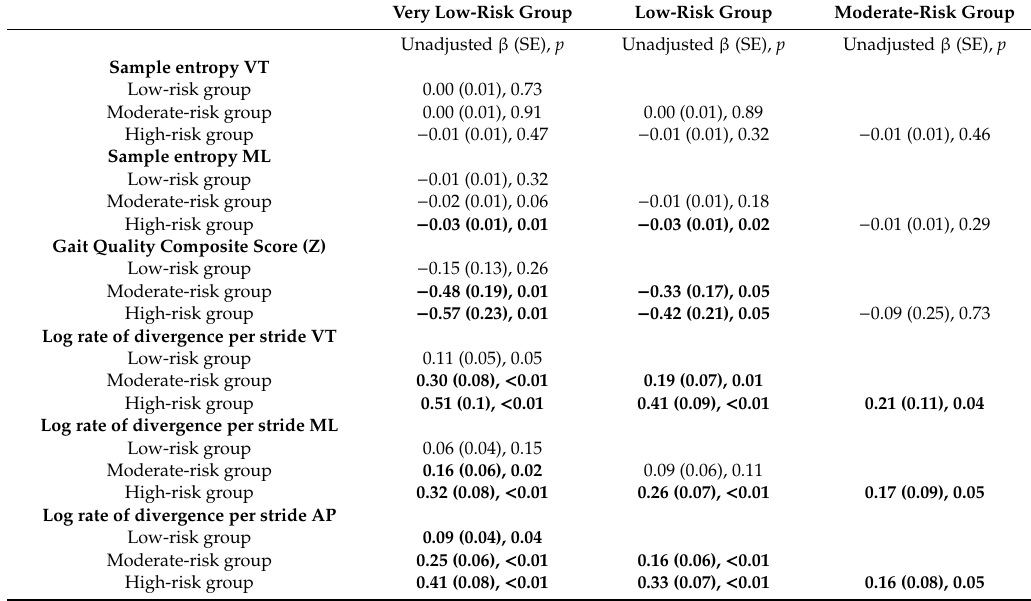
Table A1. Regression coe ffi cients ( β ) with standard errors (SE) for the linear regression models adjusted for walking